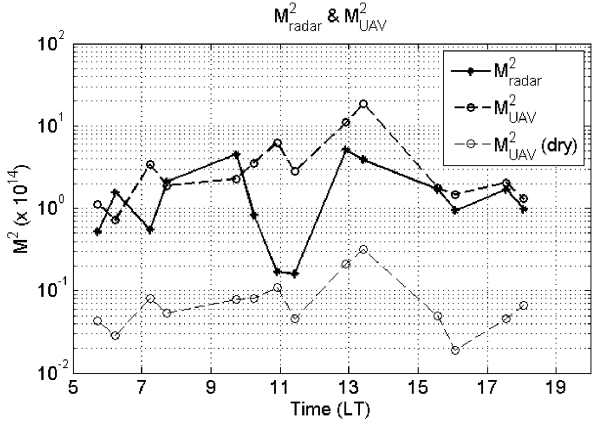
( × 10 14 ) (humid and dry) and UAV